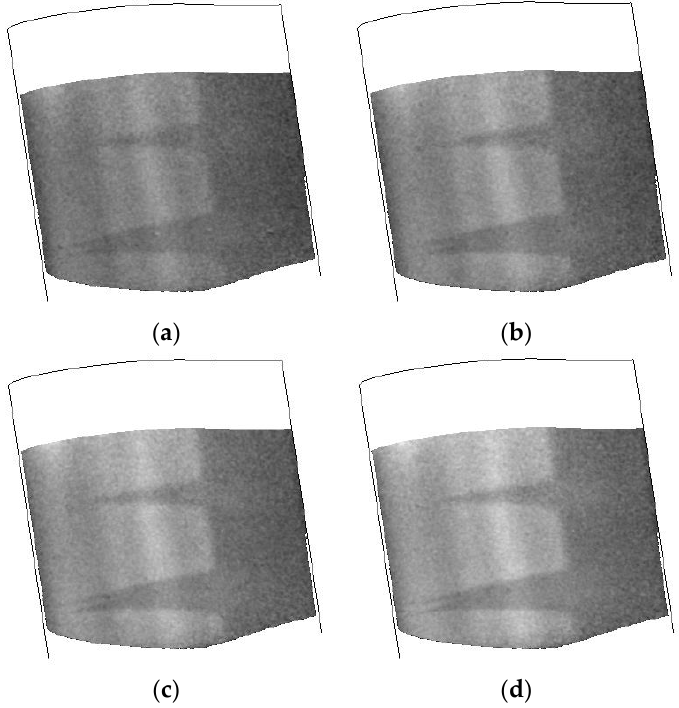
Figure 10. Temperature images collected during a CNT heating cycle (100 V). Data were collected at T = 200 K, Mach 0.7, Re = 32.8 M/m: ( a ) 1.5 s; ( b ) 3 s; ( c ) 4.5 s; and ( d ) 6 s. All times are after start of the heating cycle.